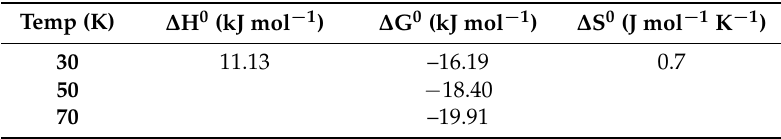
Table 3. Thermodynamic parameters of Pb(II) adsorbed onto ZnO-Nano-A.